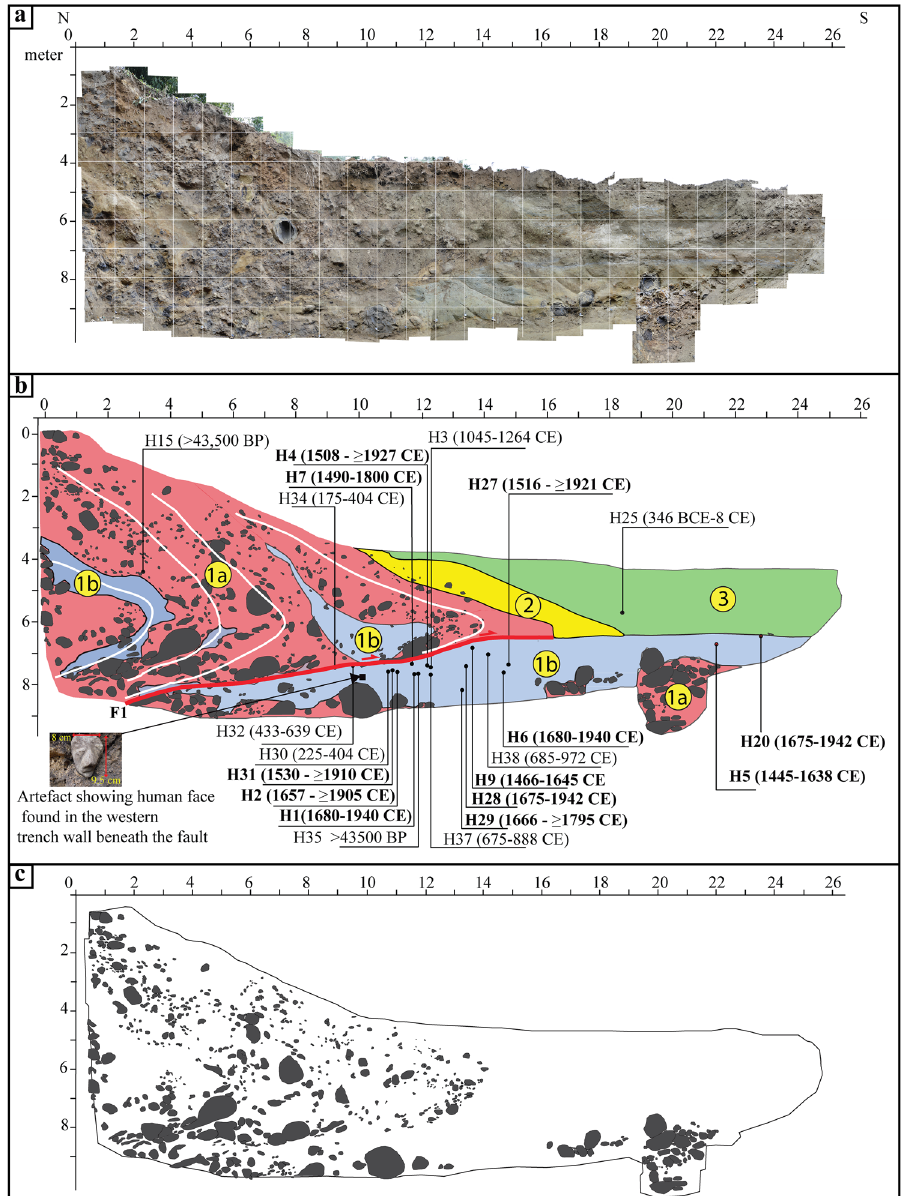
Figure 4. ( a ) Photomosaic of the excavated trench exposures at Himebasti site showing 1 × 1 m grids. Horizontal and vertical scales are in meters. ( b ) Illustrative log of the trench exposures shown in ( a ) showing different stratigraphic units (numbers in yellow circles) concerning the faulting events (red) and the sample locations showing 2-sigma values. A solid black square depicts the location of an artifact of human face. ( c ) Illustrative log of the trench exposure for a better understanding of the fabric. Mosaic of the trench photographs was done in Adobe Photoshop CS5 software and artwork in Adobe Illustrator CS5